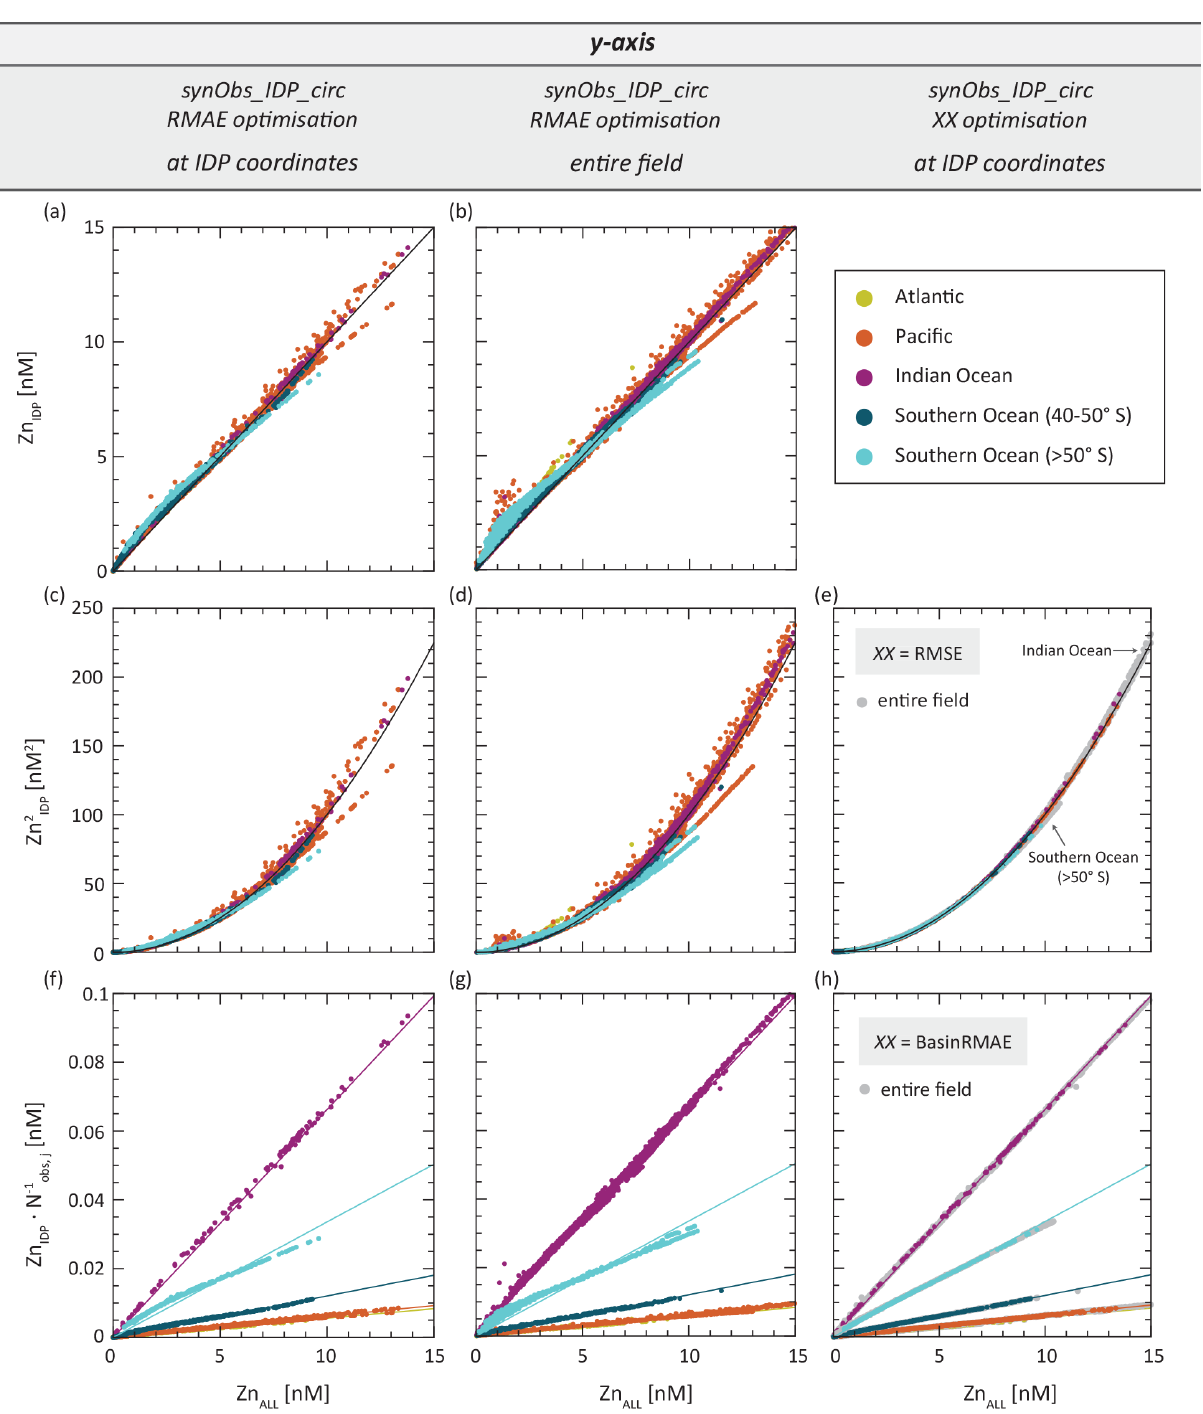
Figure 11. Comparison of Zn obtained in synObs_IDP_ circ to Zn obtained in synObs_ALL_circ. The first row compares RMAE-optimised Zn obtained in synObs_IDP_circ and synObs_ALL_circ. The second and third rows show the effect on deviations seen in the first row if either Zn is squared, as in RMSE, or five ocean regions are distinguished, as in BasinRMAE. The first and second columns plot RMAE-optimised Zn obtained in synObs_IDP_circ and synObs_ALL_circ restricted to the coordinates in the GEOTRACES IDP2017 and the entire field, respectively. Panels (e) and (h) of the third column compare Zn obtained with the RMSE misfit function and BasinRMAE misfit function in synObs_IDP_circ to the corresponding Zn obtained in synObs_ALL_circ, respectively.